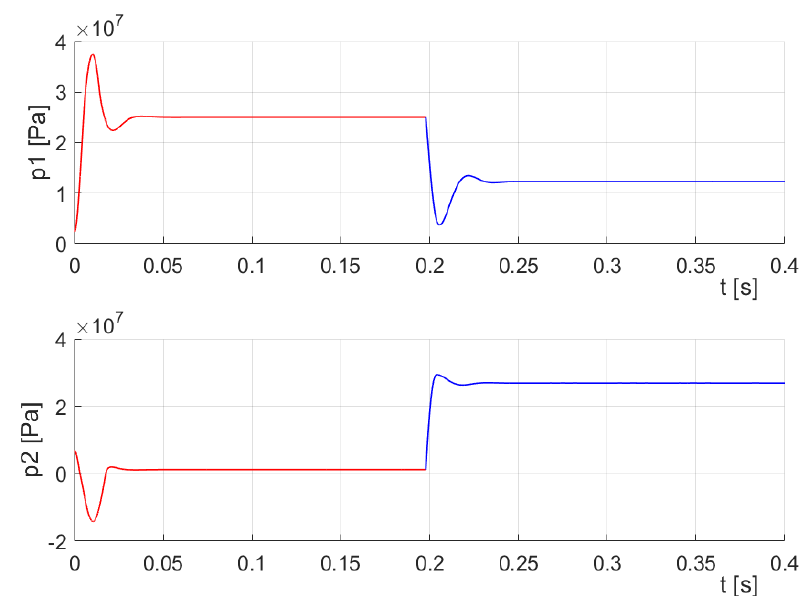
Figure 10. Pressure p 1 ( t ) in the working cylinder and pressure p 2 ( t ) in the return cylinders.